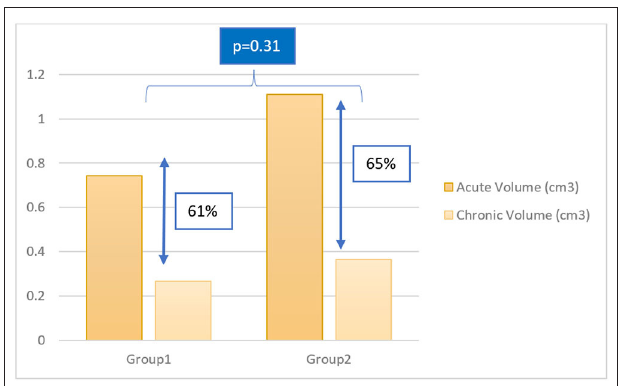
FIGURE 5 | Column chart of acute and chronic lesion volumes in group 1 and group 2. Group 1: follow up in 47–54 days; Group 2: follow up in 72–82 days.